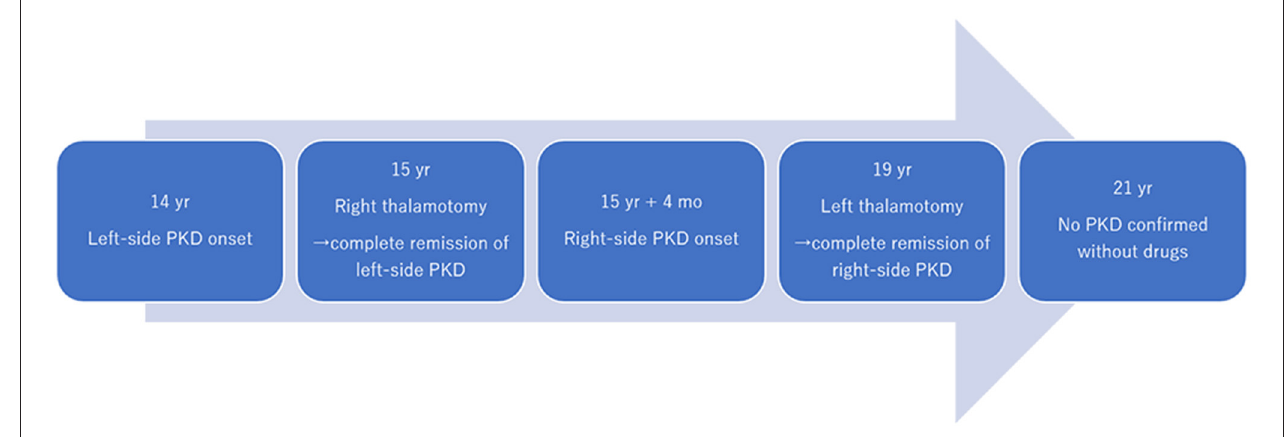
FIGURE 2 | Time course of symptoms and interventions. PKD, paroxysmal kinesigenic dyskinesia; yrs, years; mo, month.